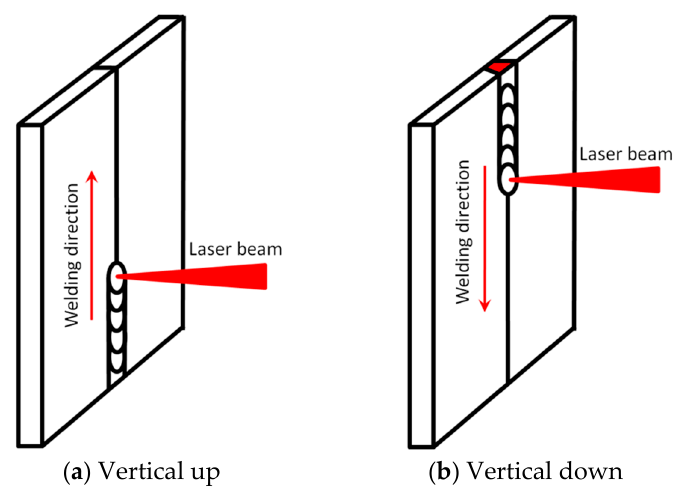
Figure 1. The shielding scheme adopted in this study.